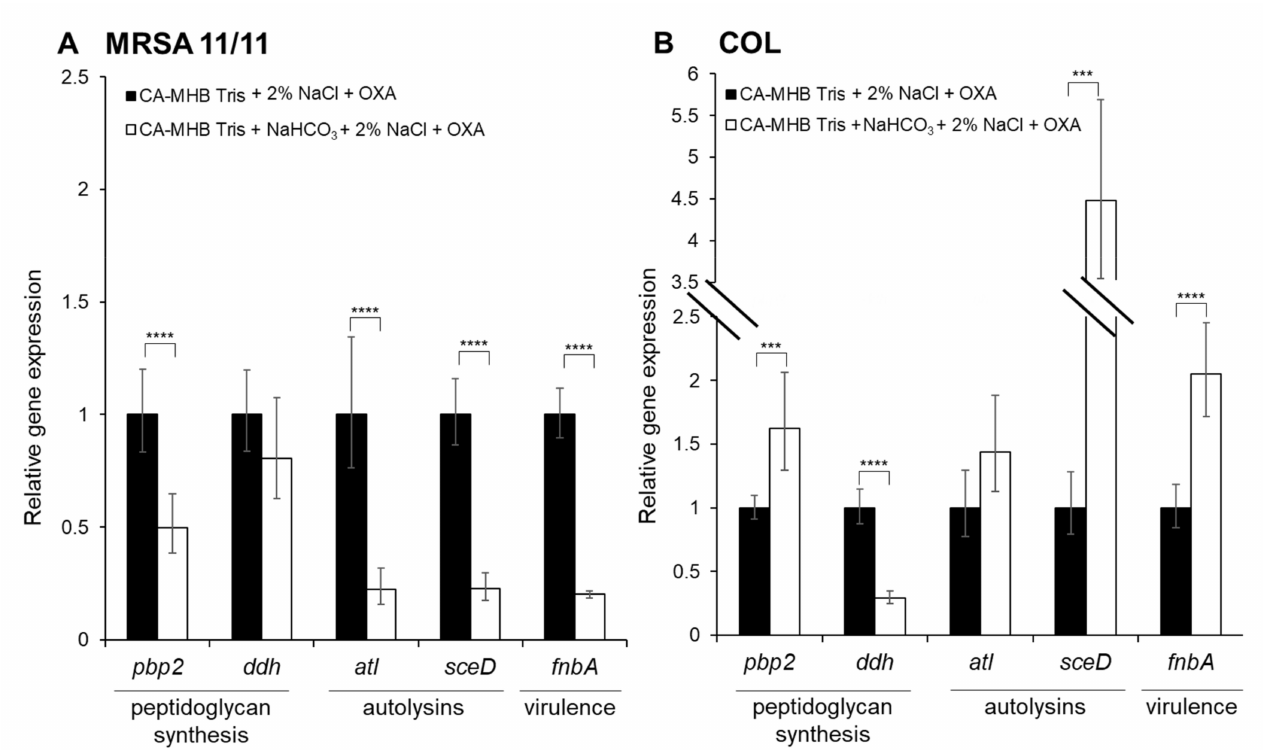
Figure 3. qRT-PCR confirmation of the expression of key genes-of-interest from RNA-seq analysis in: ( A ) MRSA 11/11, NaHCO 3 -responsive strain; and ( B ) COL, non-responsive strain. Expression was determined in log phase MRSA 11/11 and COL strains, each grown in the presence of 1 x MIC OXA. For each gene, expression is normalized to that observed for the 2 × MIC OXA (CA-MHB Tris + 2% NaCl + 1 × MIC OXA expression indicated strain grown in CA-MHB Tris+2% NaCl + 1 2 2 set at 1.0). Statistics were calculated by Student’s t -test (*** P < 0.001, **** P <